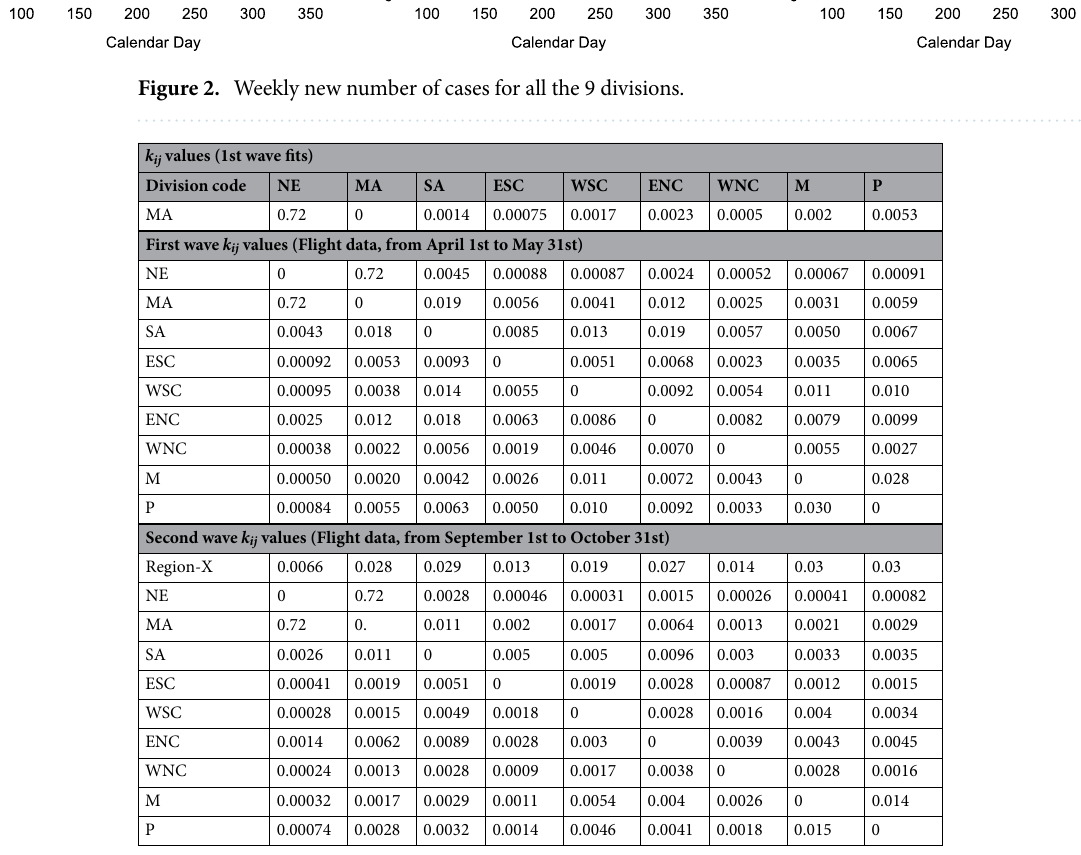
Table 2. Values of the k ij entries among US divisions. In the top section, the values between Mid-Atlantic (MA) and the other divisions are obtained from fits of the first wave timing. In the central and bottom